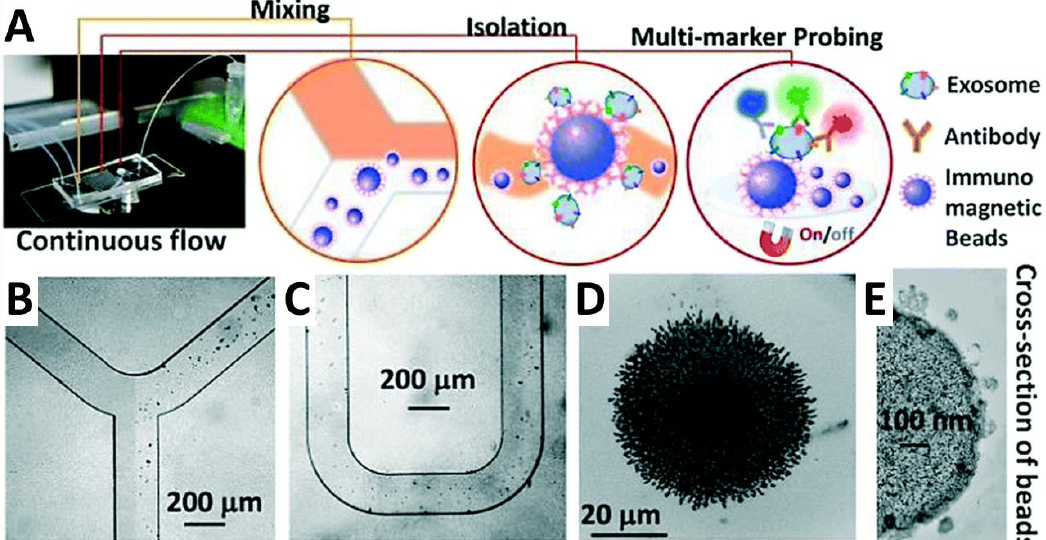
Figure 9. Workflow of the ExoSearch chip developed by Zhao et al. [257]. ( A ) Patient plasma (orange) is mixed with immunomagnetic beads that bind exosomes within the sample. Beads carrying exosomes are then isolated via a magnetized field in which the number of beads isolated was in direct comparison to the sample input and could be quantified. A mixture of fluorescently labeled antibodies is then applied to the isolated beads for multi-color fluorescence imaging. ( B , C ) Bright-field images of the immunomagnetic beads in the microfluidic compartments. ( D ) Aggregated exosome-bound immunomagnetic beads after magnetic separation ( E ) Transmission electron micrograph depicting the cross-section of an exosome-bound immunomagnetic bead. Reprinted under the Creative Commons CC BY-NC3.0 license.